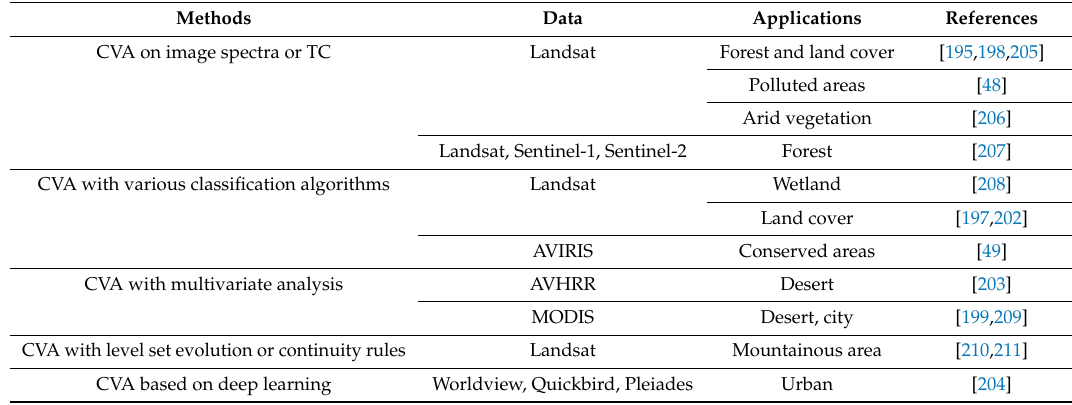
Table 3. Research that has applied change vector analysis (CVA) as a single technique or in combination with other methods to produce magnitude and direction of change information for various